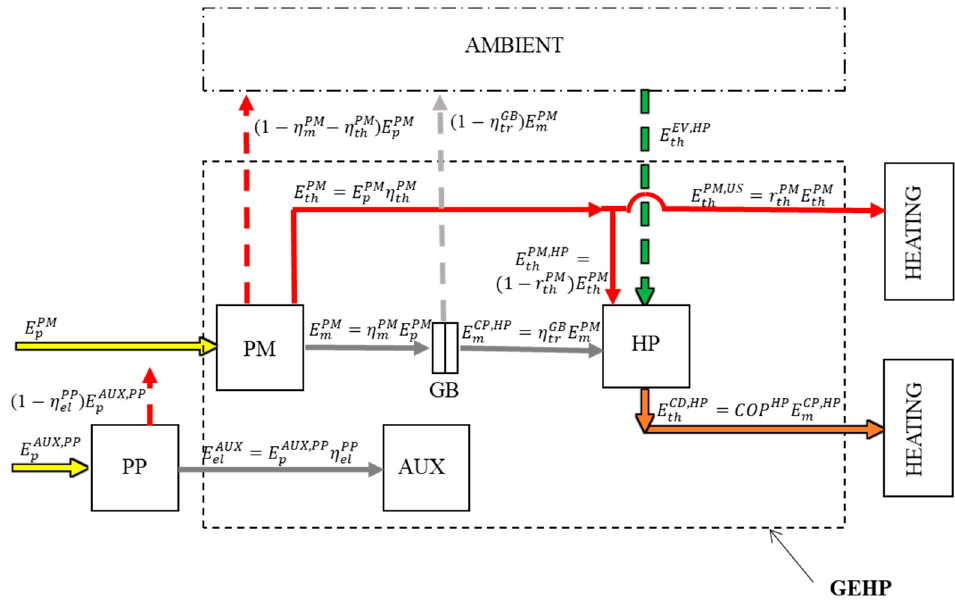
Figure 15. GEHP in heating operating mode with indirect engine heat recovery.